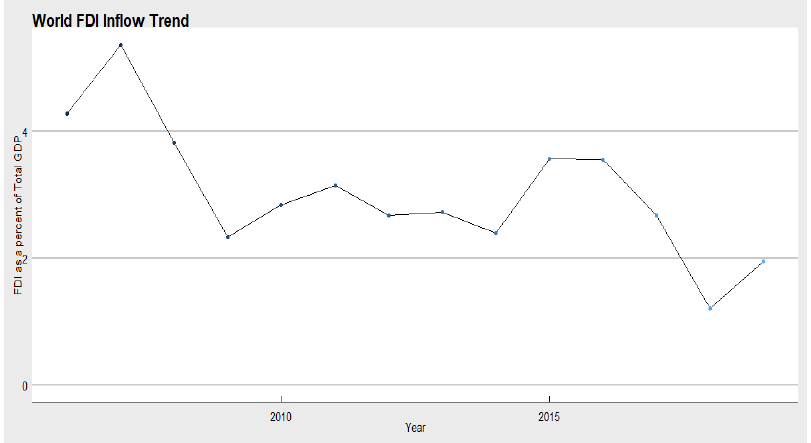
Figure 2. World trends in FDI as a percentage of GDP.